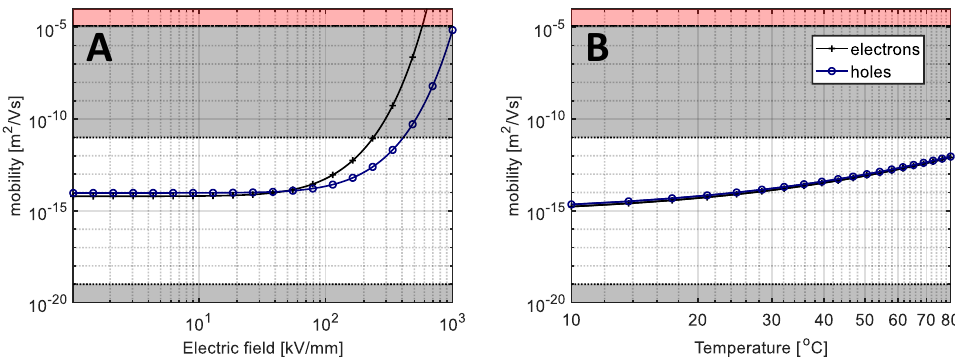
Figure 6. Apparent mobilities as functions of the field strength at 25 °C ( A ) and temperature at 30 kV/mm ( B ) obtained with the parameters from Table 1. Gray areas indicate regions where the base levels are out of realistic range. The red area indicates the postulated hot electron limit (limit for band theory at 1.2·10 −5 m 2 /(V·s) [22]).